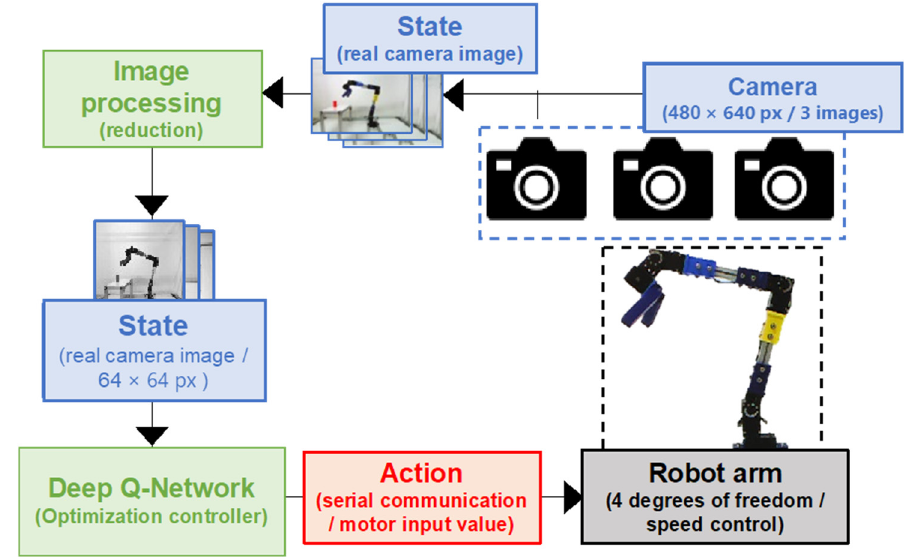
Figure 5. Proposed deep learning control scheme.